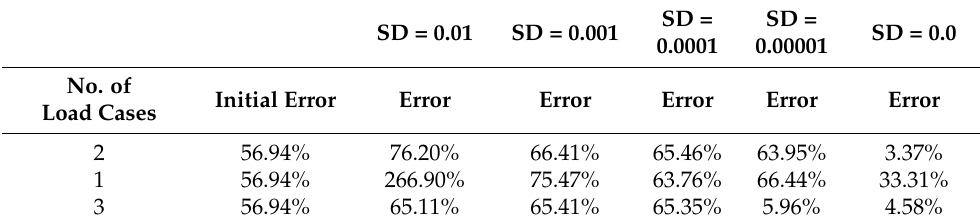
Table 5. Errors obtained for the TMM thermal parameters. Correlation of transient 4 nodes model with 1 unknown temperature.